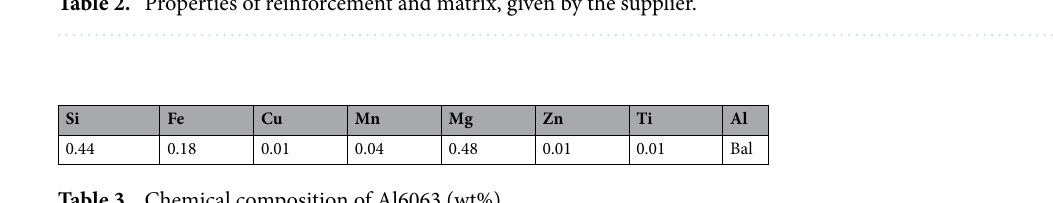
Table 3. Chemical composition of Al6063